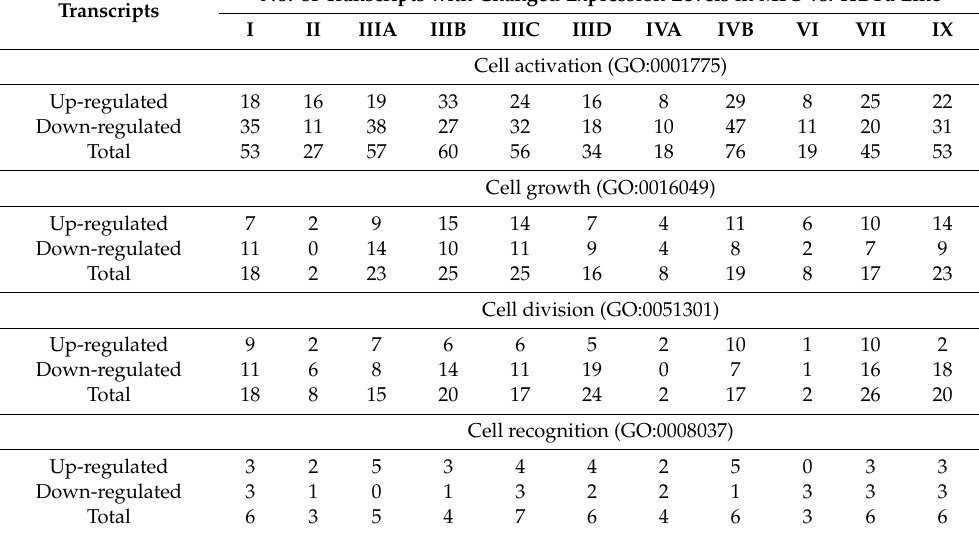
Table 3. Number of up- and down-regulated transcripts related to cell activation, growth, division and recognition processes (according to the QuickGO database) in di ff erent types of MPS relative to HDFa